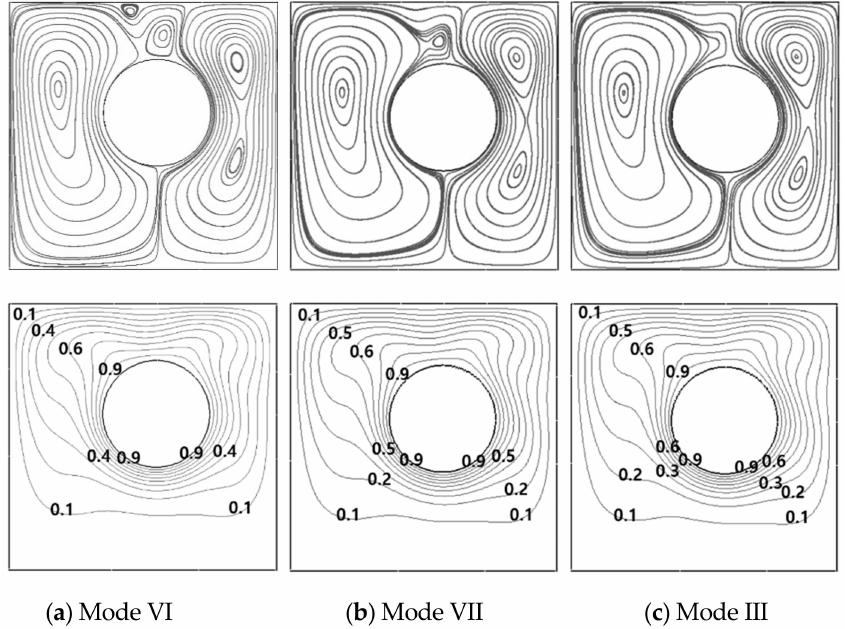
Figure 16. Streamlines (upper row) and isotherms (lower row) at ( a ) θ = 60 ◦ , ( b ) θ = 45 ◦ and ( c ) θ = 40 ◦ at a fixed r = 0.1 L for Ra = 10 5